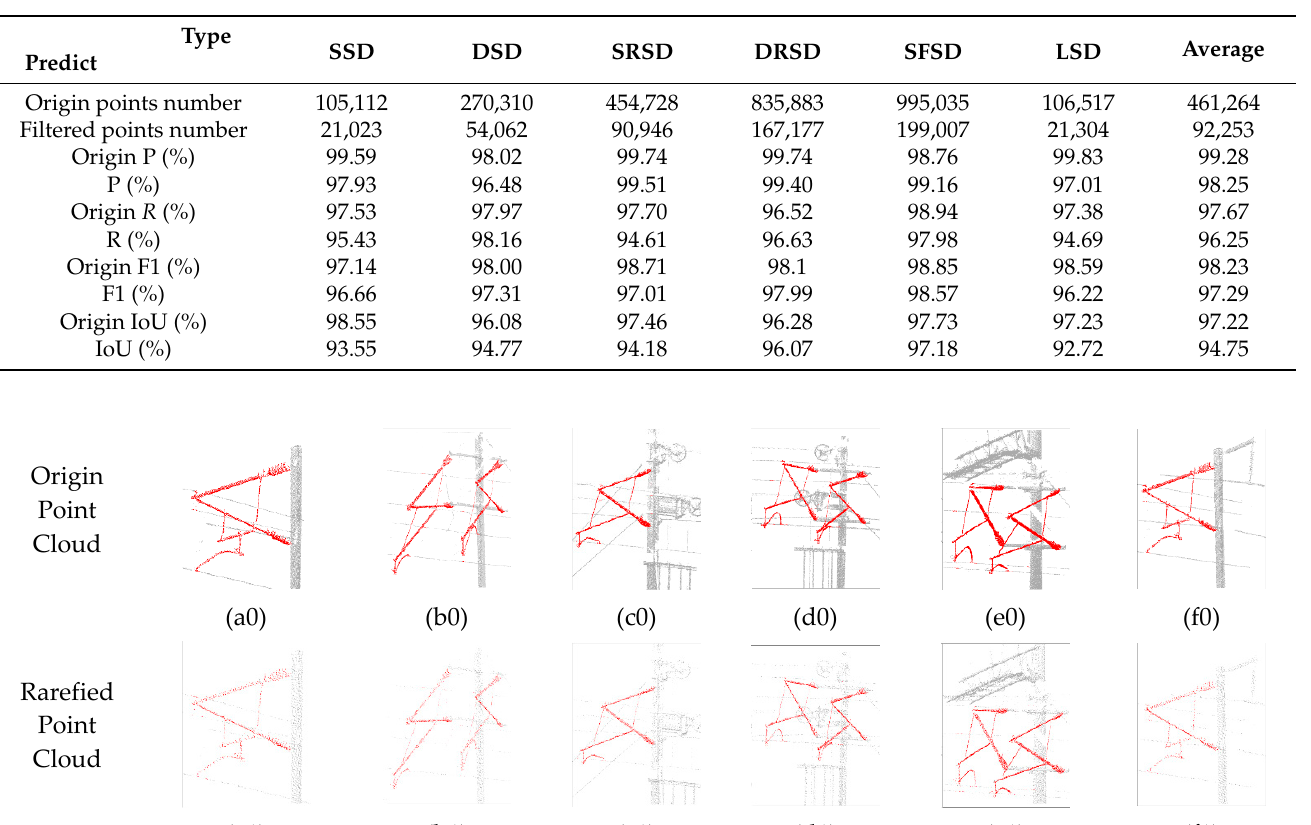
Table 5. Test results.